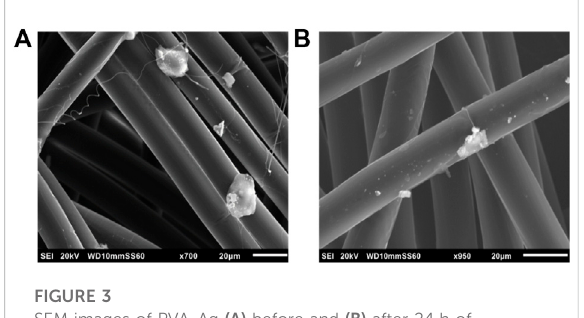
FIGURE 3 SEM images of PVA-Ag (A) before and (B) after 24 h of immersion in synthetic sweat.